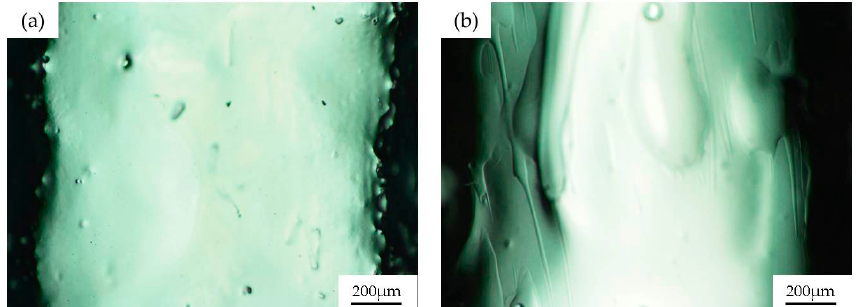
Figure 5. Microscopy images of PDMS channel: ( a ) uncoated and ( b ) with sol-gel coating.